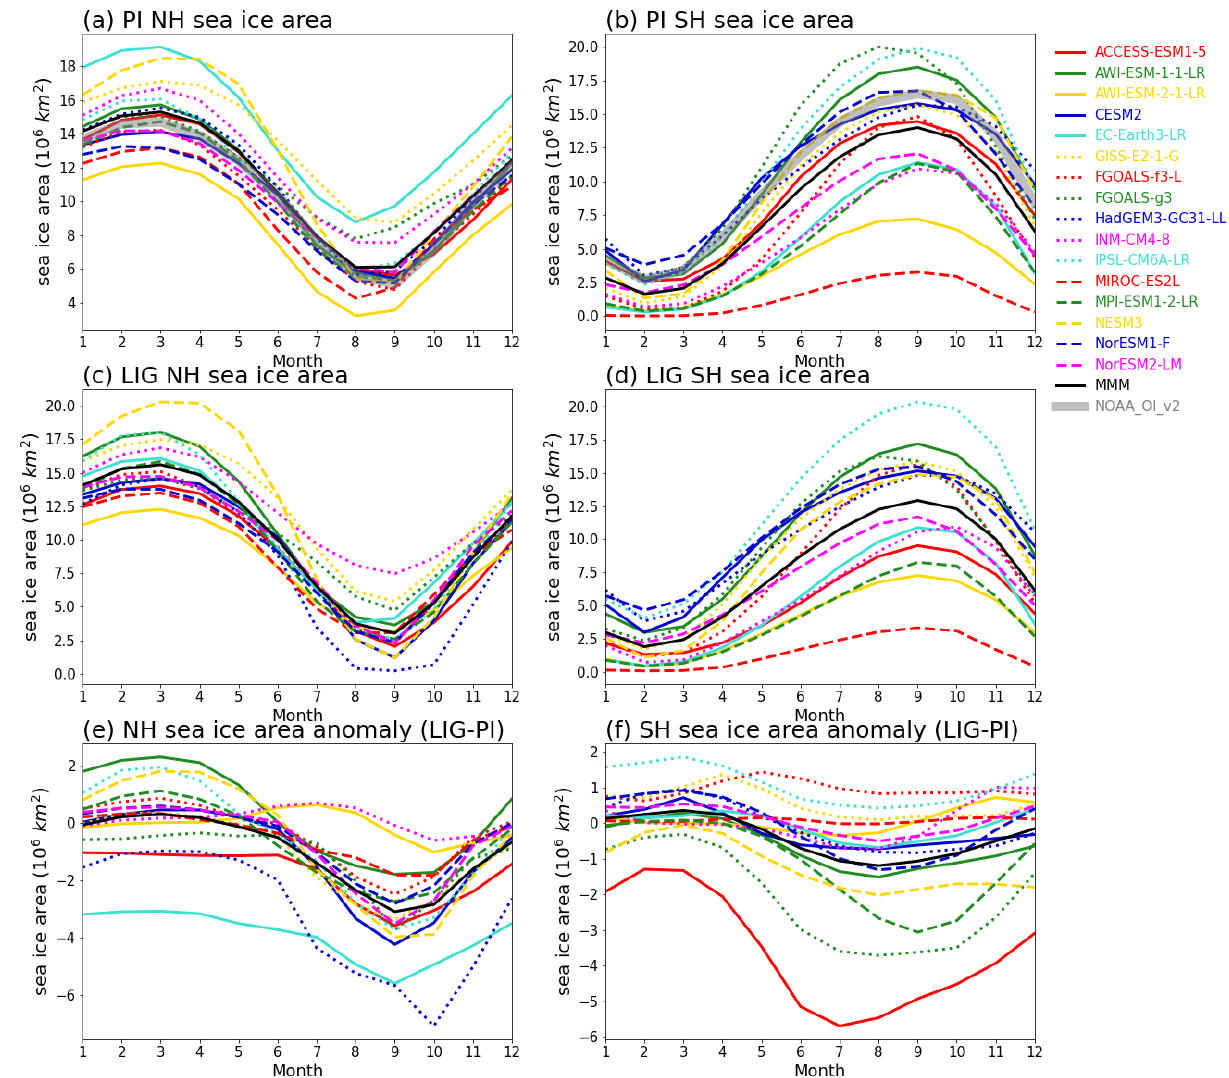
Figure 4. The simulated Arctic (a, c, e) and Antarctic (b, d, f) annual cycle of sea ice area (10 6 km 2 ) for the (a, b) PI, (c, d) LIG, and (e, f) LIG minus PI. The monthly mean sea ice areas from the NOAA_OI_v2 dataset for 1982–2001 (Reynolds et al., 2002) are shown in panels (a) and (b)